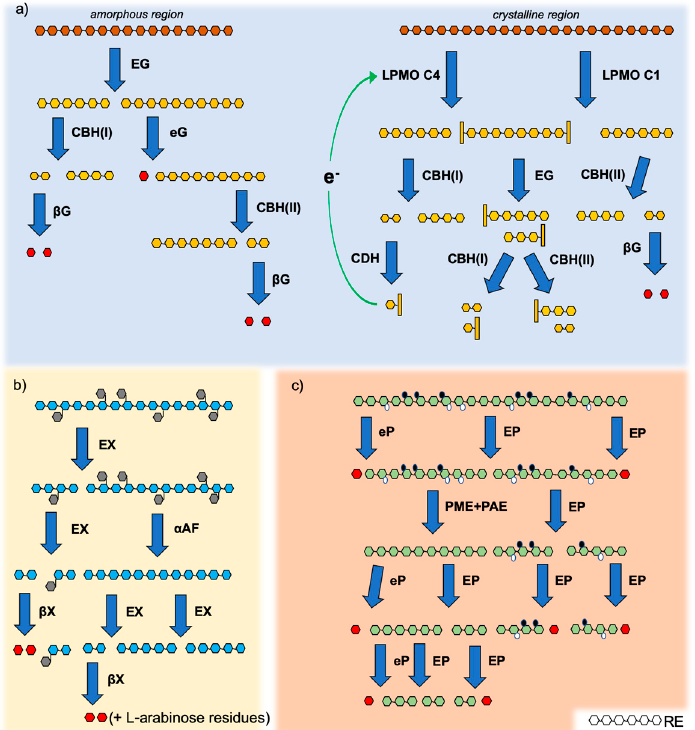
Figure 2. Schematic representation of cell wall polysaccharides and their degradation by CWLEs. ( a ) Degradation of (left) amorphous and (right) crystalline cellulose. Intermediate (yellow) and end-products (red) from each enzymatic reaction are shown. Oxidized glucose (i.e., gluconic acid) is represented as a rectangle. Cellobiose oxidation by cellobiose dehydrogenase (CDH) restores electrons (e-) to the lytic polysaccharide monooxygenase (LPMO). ( b ) Degradation of arabinoxylan, here reported as representative hemicellulose polysaccharide. Arabinose residues are in grey. Intermediate (turquoise) and end-products (red) from each enzymatic reaction are shown. ( c ) Degradation of substituted homogalacturonan, here reported as representative pectin polysaccharide. Intermediate (green) and end-products (red) of each reaction are reported. Acetyl and methyl groups are indicated as white and black circles, respectively. As a reference, the reducing end (RE) is indicated on the oligosaccharide in the white rectangle. α AF: α -arabinofuranosidase, β G: β -glucosidase, β X: β - xylosidase, CBH(I): nonreducing-end cellobiohydrolase, CBH(II): reducing-end cellobiohydrolase,